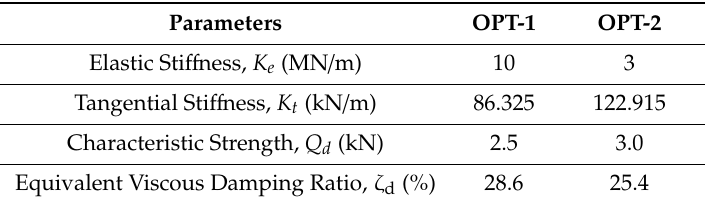
Table 4. Design bilinear characteristics and damping